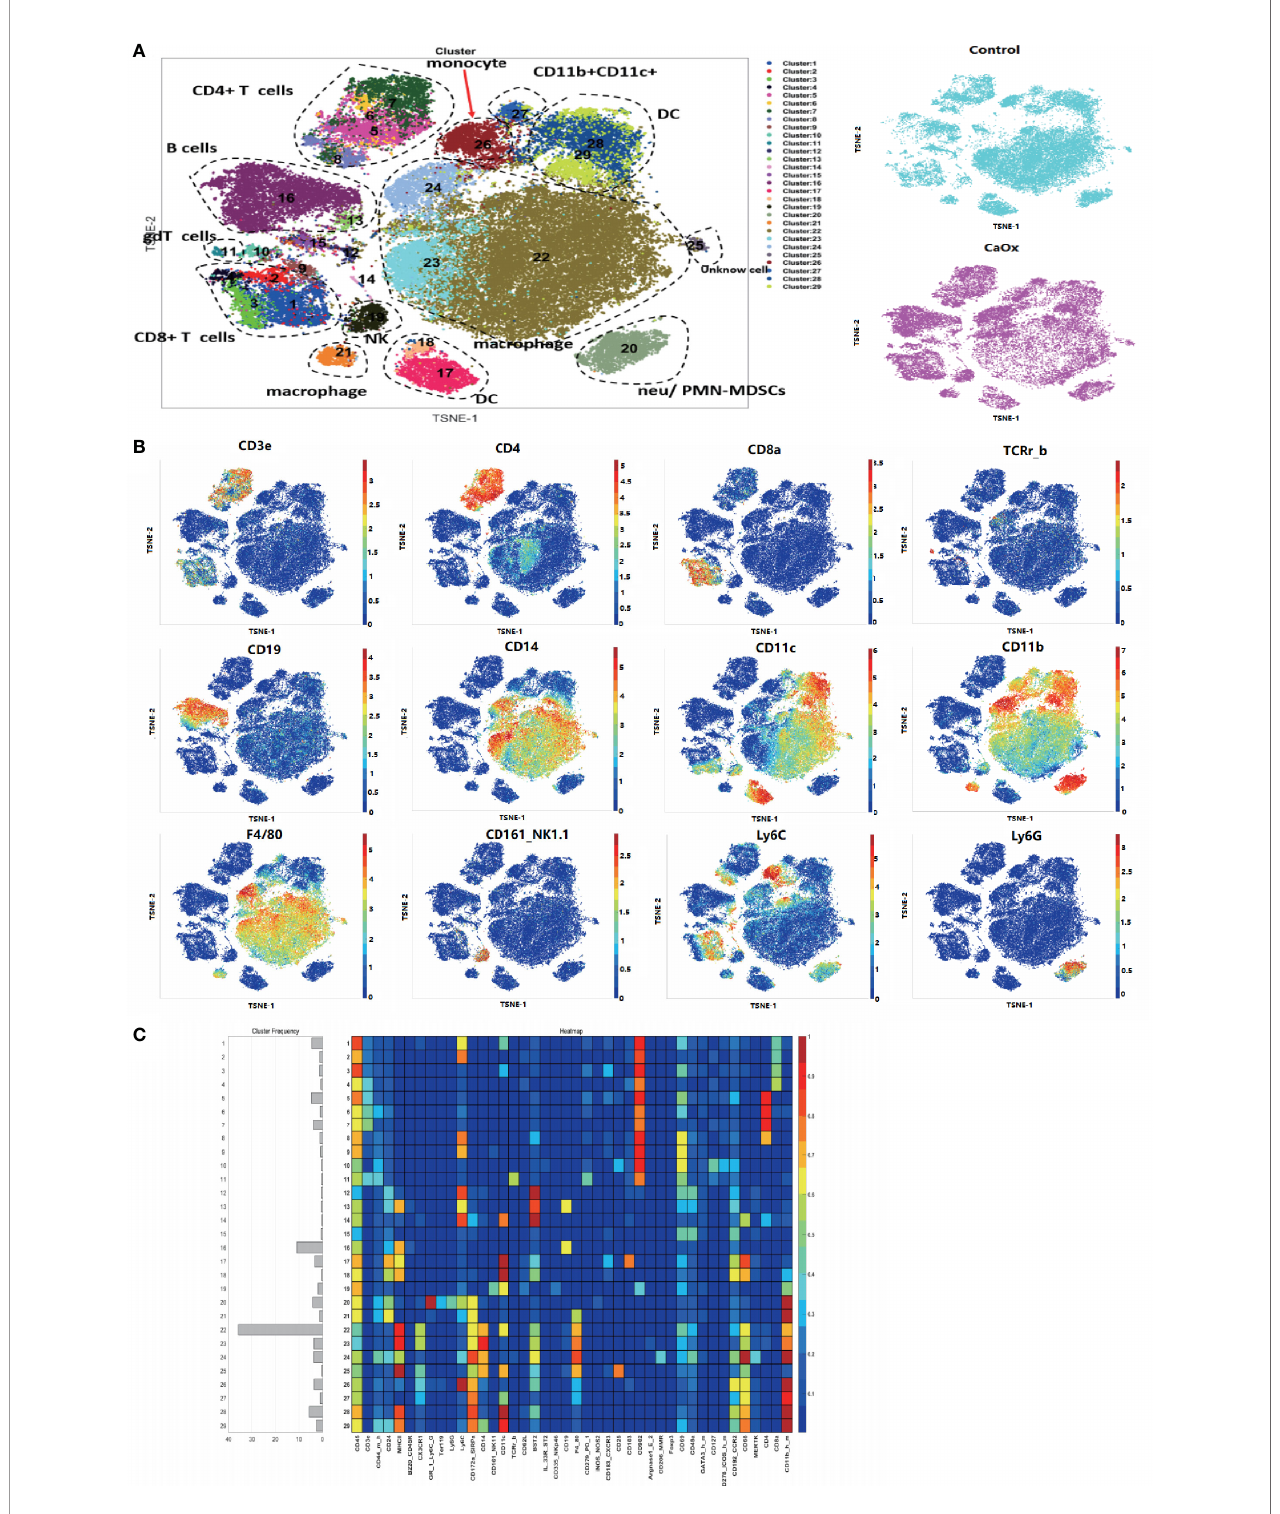
FIGURE 1 | Identi fi cation of immune cell populations in kidney using mass cytometry. (A) tSNE visualization of 383,985 renal CD45 + cells merged events from control mice and CaOx mice. (B) Feature plots shows the canonical markers of immune cells including CD3, CD8, CD4, CD19, CD14, CD11c, CD11b, F4/80, NK1.1, Ly6C, and Ly6G. (C) Heatmap of different markers in different